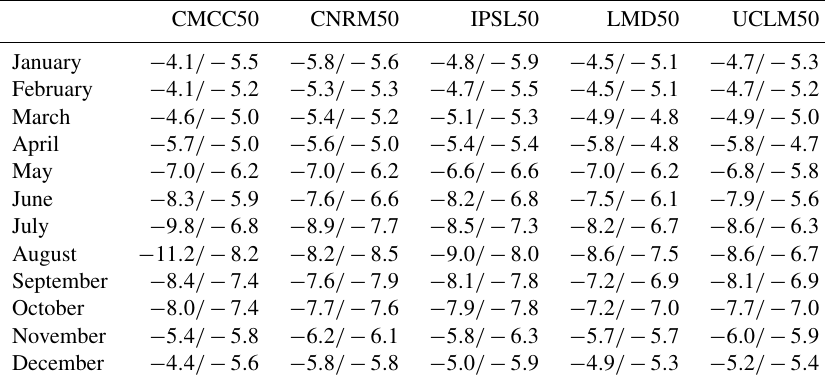
Table 2. Values of linear regression slopes obtained for each model/each month when plotting IWVmod–IWVobs as a function of the difference in altitudes between model and GPS at each station. The first figure is for native grid of the model and the second figure is for model regridded to ERAI grid. It is expressed in 10 − 3 kgm − 3